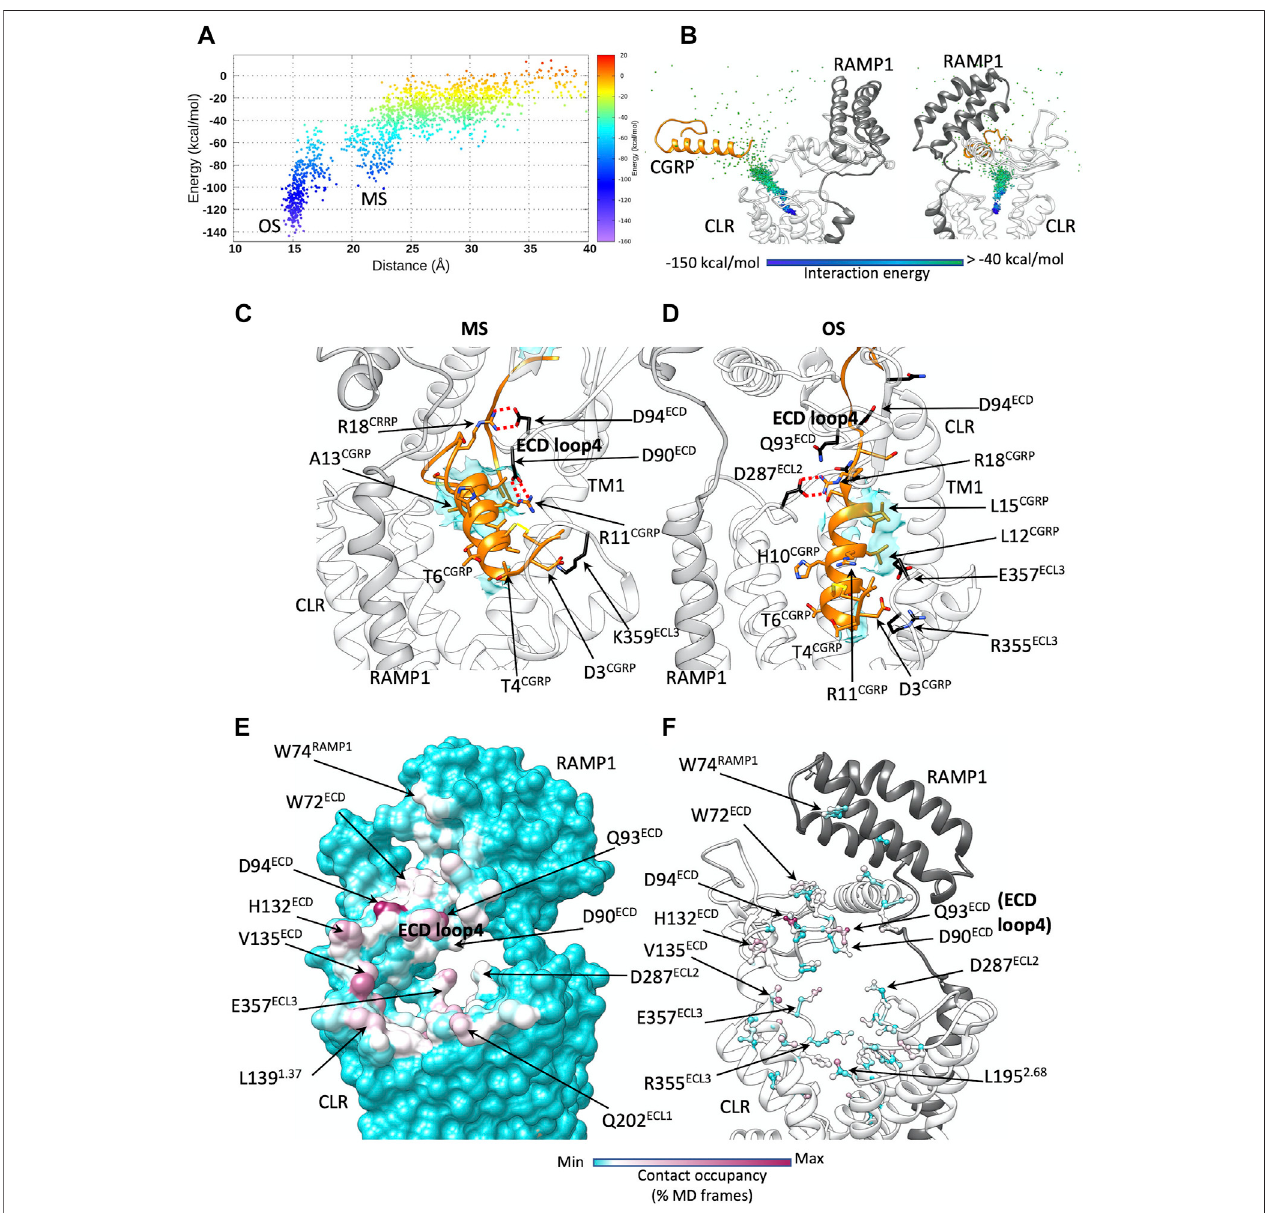
FIGURE 2 | CGRP dynamic docking. (A) CGRP binding energy landscape; x axes report the distance between the TMD centroid and the CGRP N-terminal helix (the metastable macrostate, MS, is indicated, alongside the deep bound states OS); (B) binding path of the centroid of the CGRP N-terminal helix, colored according to the interaction energy with CGRPR; (C) representative con fi guration from the macrostate MS. CGRPR ECD loop 4 forms salt bridges with CGRP R11 and R18; (D) representative con fi guration from the deep bound states OS. Electrostatic interactions are depicted as red dashed lines, while hydrophobic contacts are depicted as cyan transparent surfaces. (E) CGRP-CGRPR contacts plotted on CGRPR surface and colored according to the occupancy (% MD frames) of the interactions; (F) CGRP-CGRPR contacts plotted on CGRPR atoms and colored according to the occupancy (% MD frames) of the